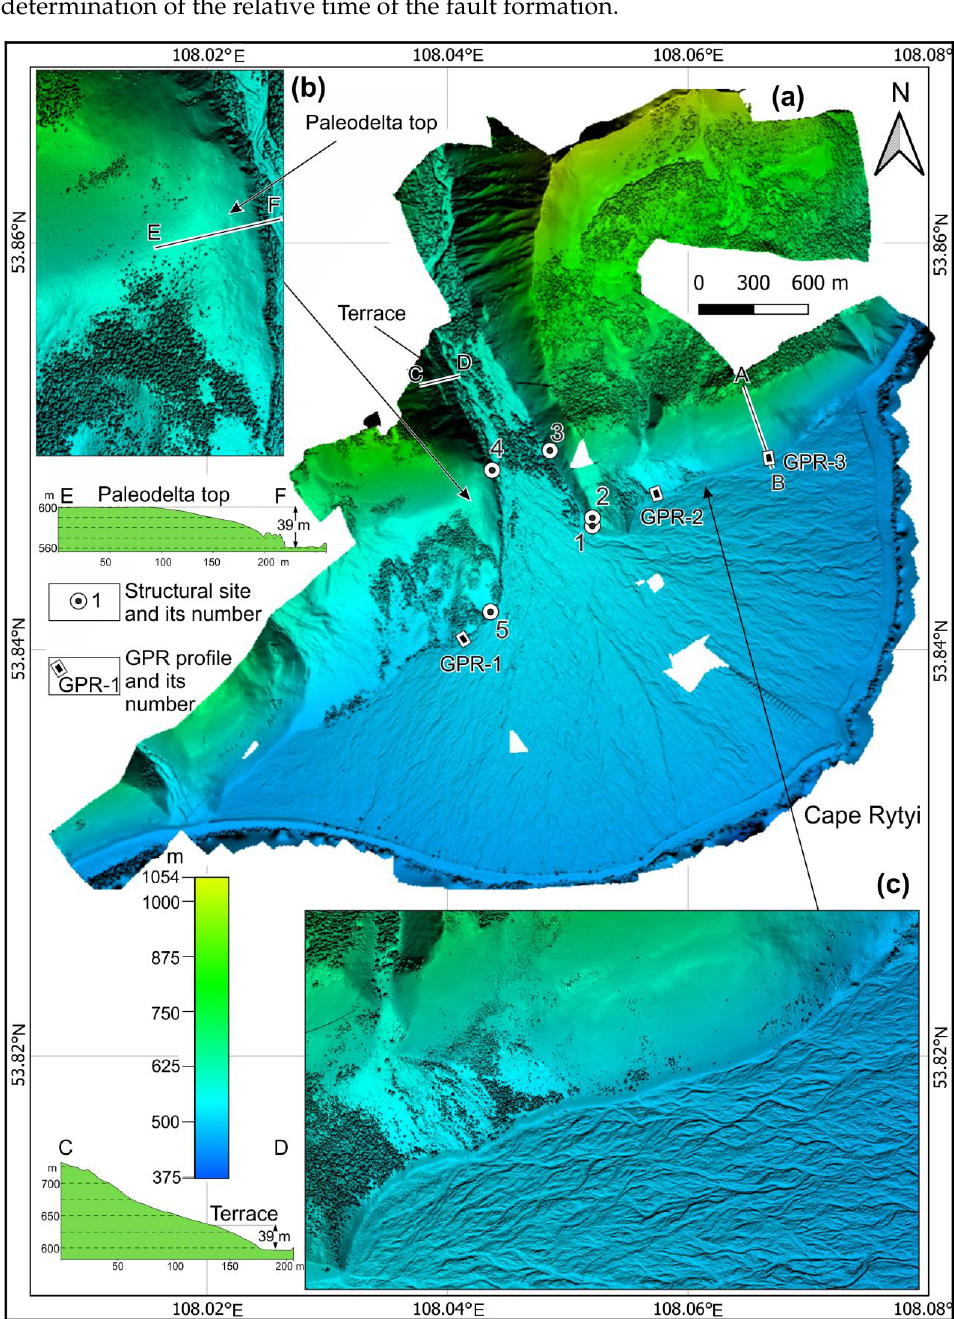
Figure 4. ( a ) Location of structural observation sites, GPR lines, and the hypsometric profiles along the A–B (discussed bellow), C–D, and E–F lines on DSM of Cape Rytyi; ( b , c ) details of DSM. The terrace is shown in Figure 3e.